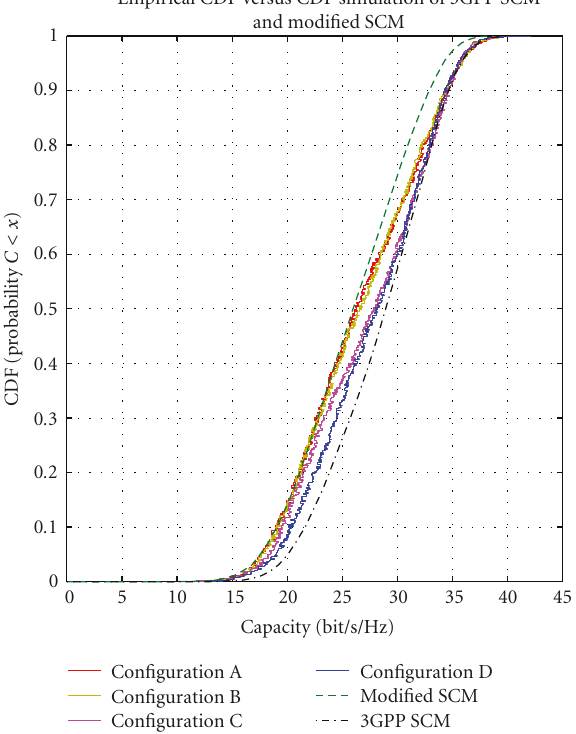
Figure 12: CDF curves of MIMO capacity: measured data (full lines) versus 3GPP SCM (dash-dotted line) and modified SCM (dashed